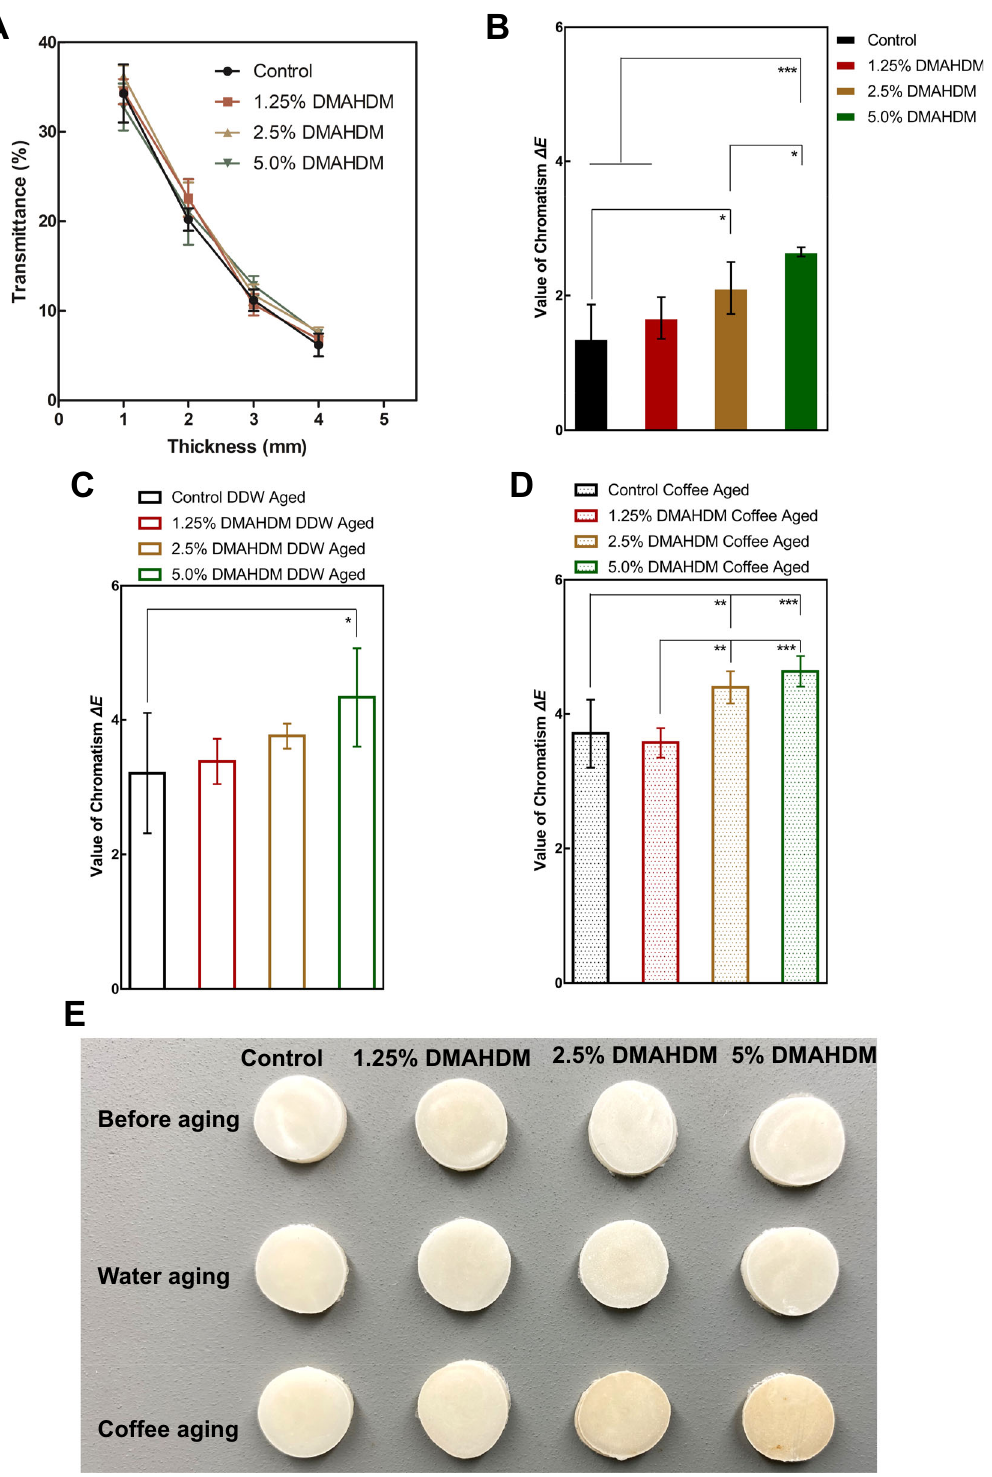
Fig. 6 Light transmission, color change and stability ( Δ E ) of resins. A Transmittance spectrum of the resins; B color change of the anti- bacterial resins compared with Control resin; C Δ E of resins after